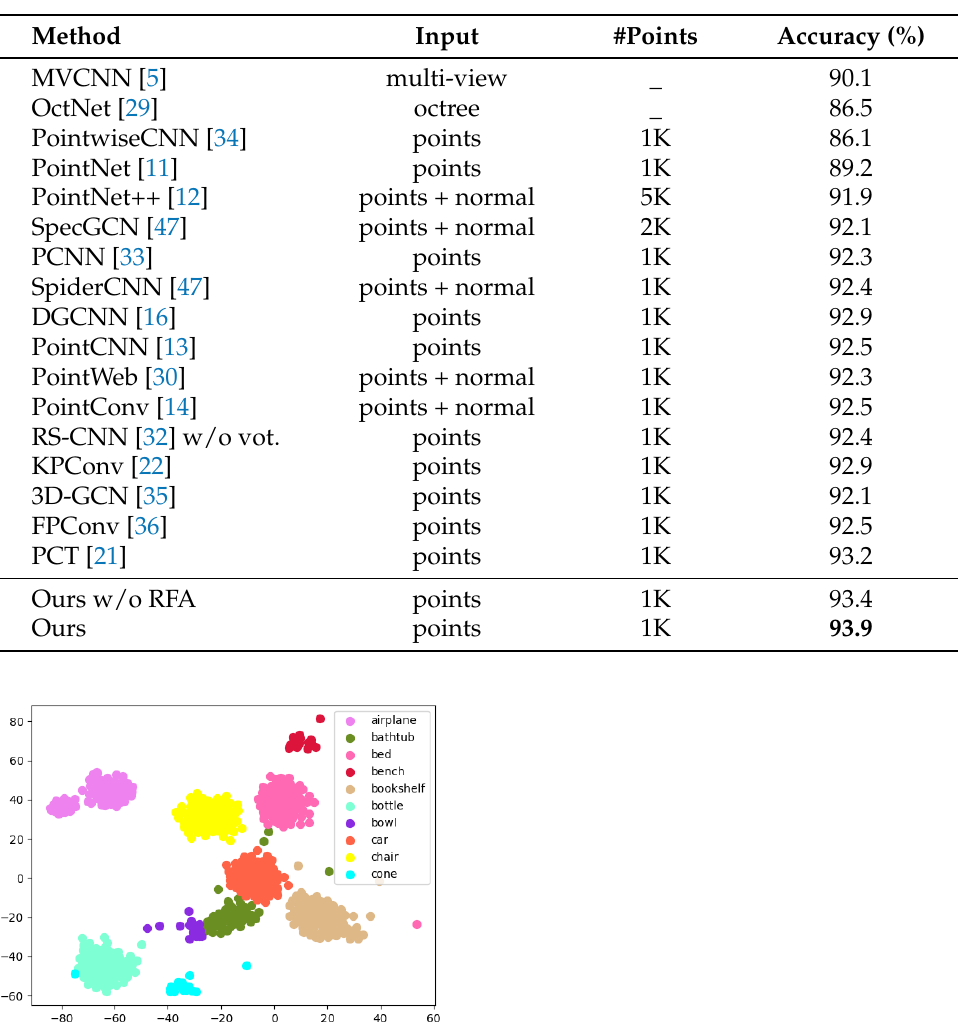
Figure 2. Visualization of learned representations on the test set of ModelNet40 using t-SNE. Best viewed in